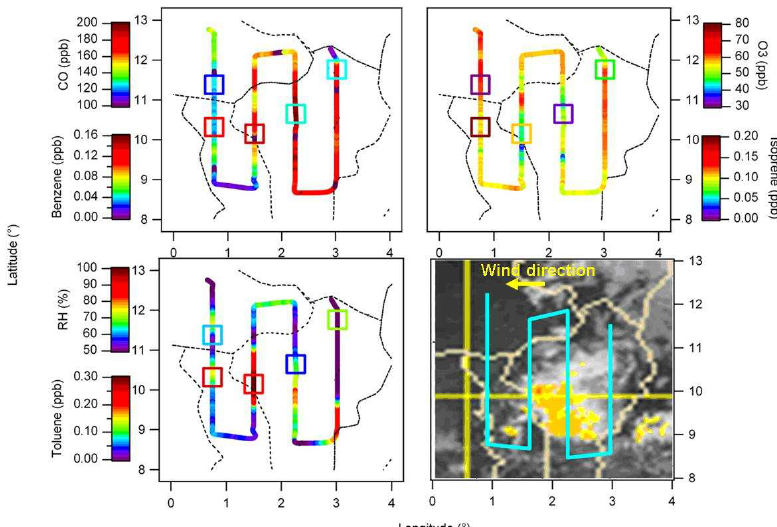
Fig. 5. Latitude vs. longitude distribution at UT level for CO (top left panel), O 3 (top right panel), RH (bottom left panel) in full line, and benzene (top left panel), isoprene (top right panel) and toluene (bottom left panel) in squares. The boxes location corresponds to the middle of the sampling time of 10min. Each flight leg corresponds to 30min. Flight track is superimposed on the Meteosat satellite picture at 14:00UTC in bottom right panel. The flight took place on 15 August between 12:35 UTC and 16:57 UTC.